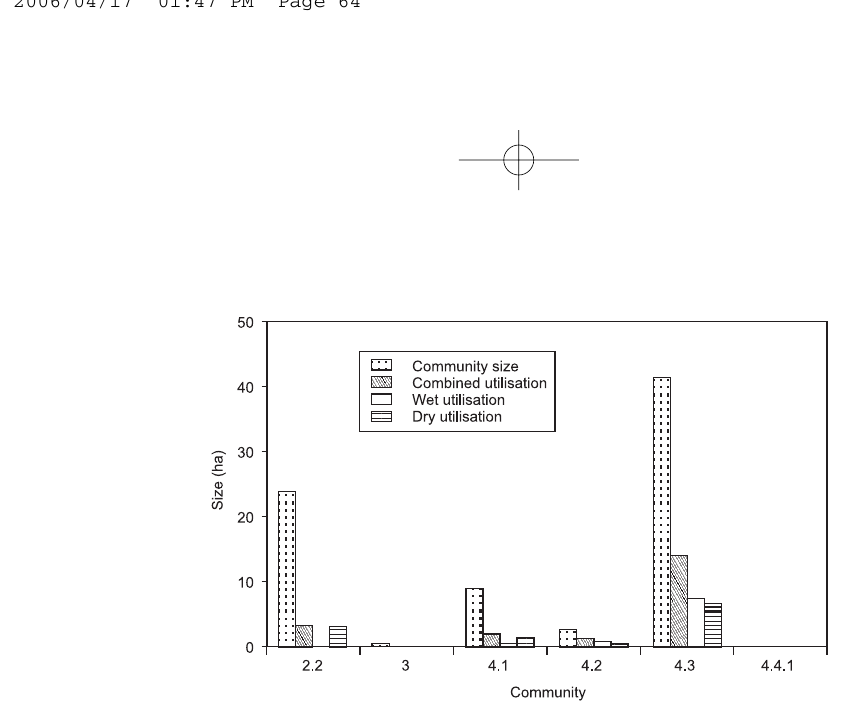
Fig. 5. Community utilisation by vervets for wet and dry seasons in the Blydeberg